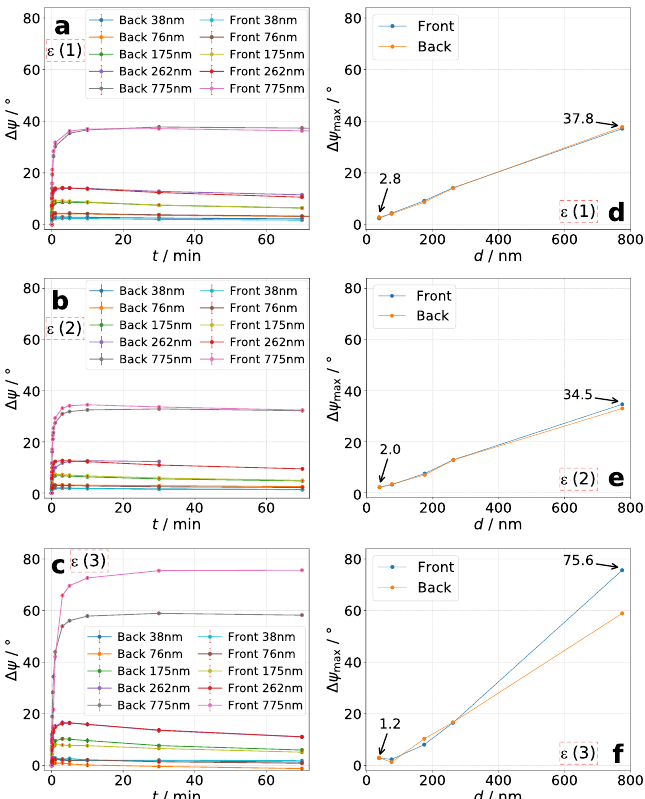
Figure 6. Polymer P3 : Time-resolved ∆ ψ for various d ( a – c ) and its corresponding ∆ ψ max ( d – f ) for each sample. Ellipticity combination: ( a , d ): (cid:101) ( 1 ) , ( b , e ): (cid:101) ( 2 ) , and ( c , f ): (cid:101) ( 3 ) (see Table 2). The long-term excitation with λ e for exposure times up to 700 min shows for all is independent on the irradiated side of the sample (azo or glass-side).